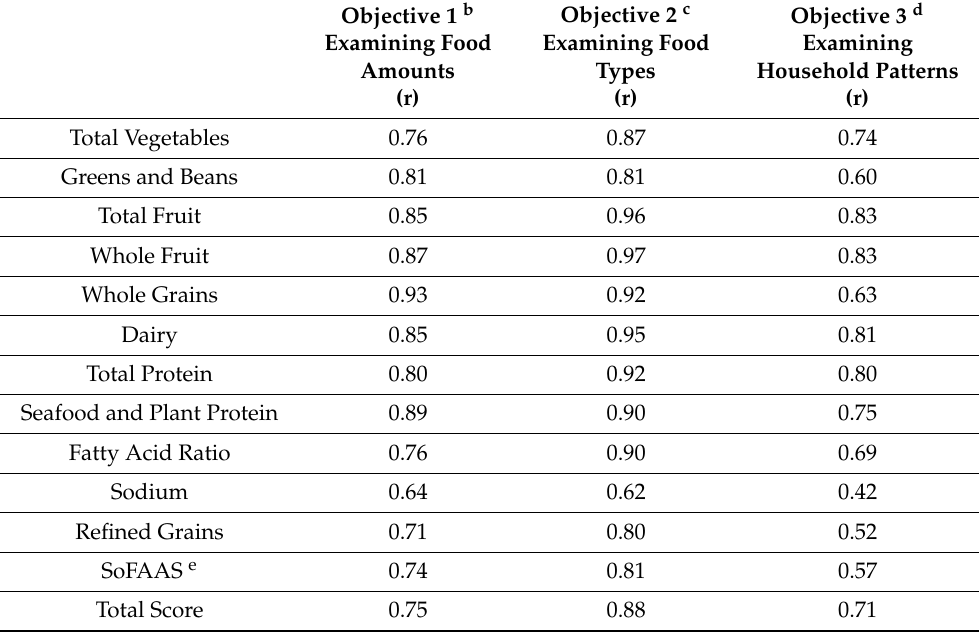
Table 3. Correlations between the Healthy Eating Index (HEI) component and total scores for each study objective a